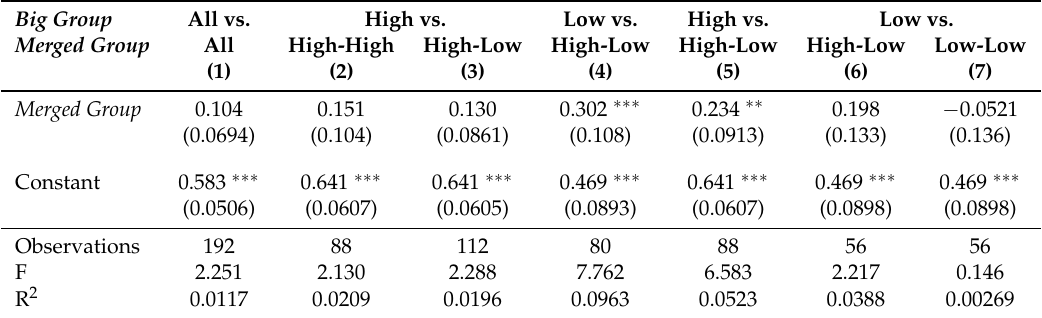
Table A15. Linear regressions: between treatment helping rates in Period 11.